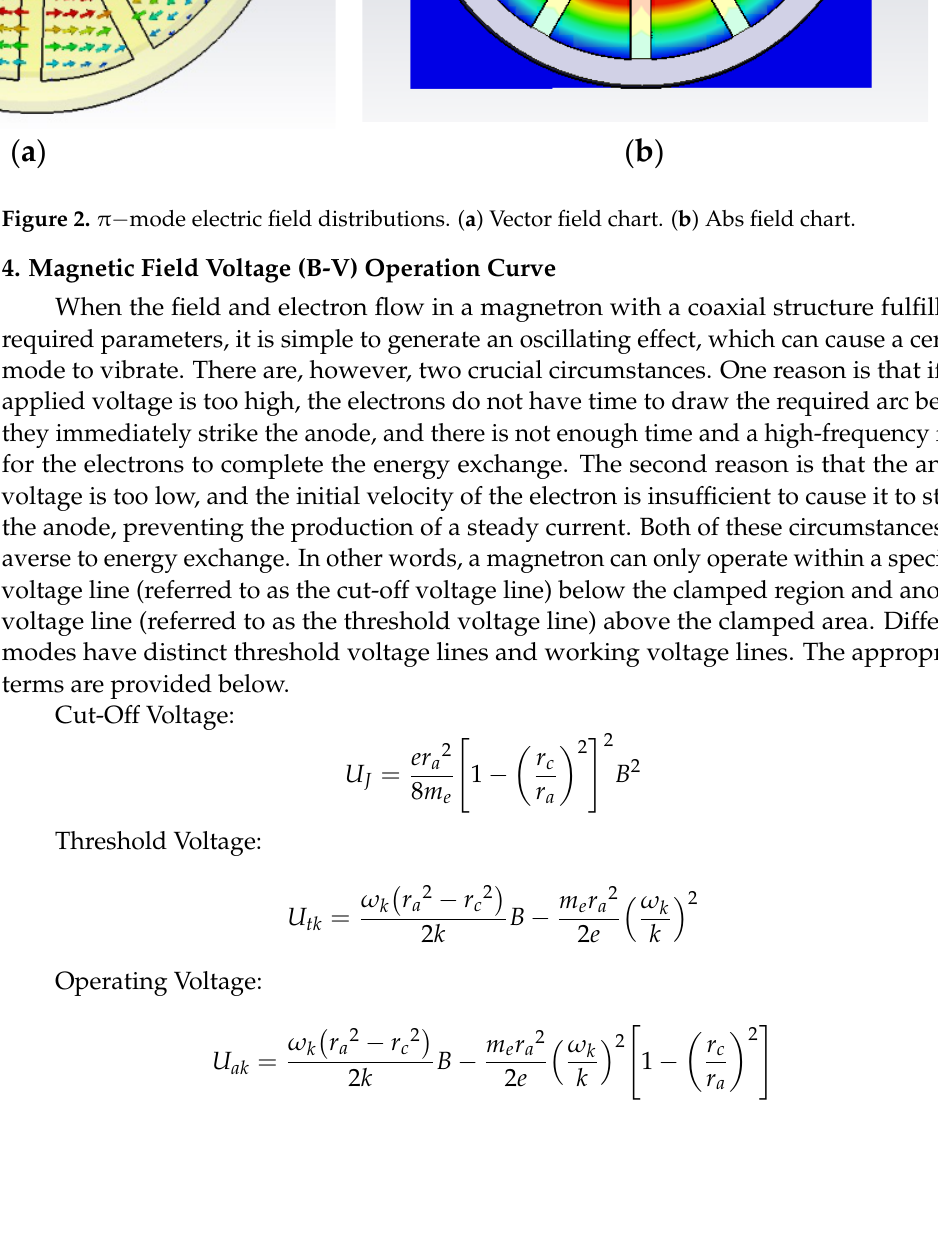
Figure 2. π− mode electric field distributions. ( a ) Vector field chart. ( b ) Abs field chart. Figure 2. π − mode electric field distributions. ( a ) Vector field chart. ( b ) Abs field